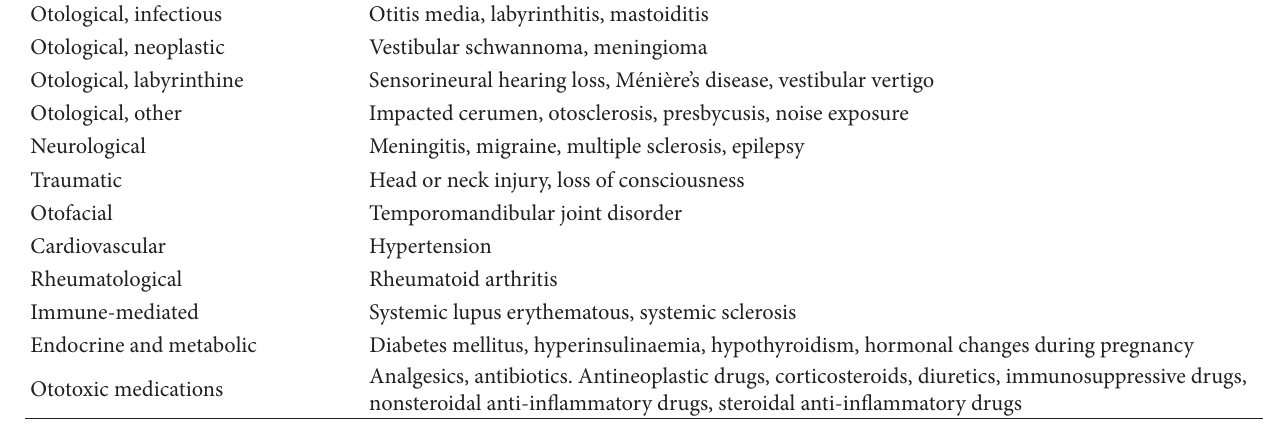
Table 1: Common systemic neurootological risk factors for developing tinnitus [36].